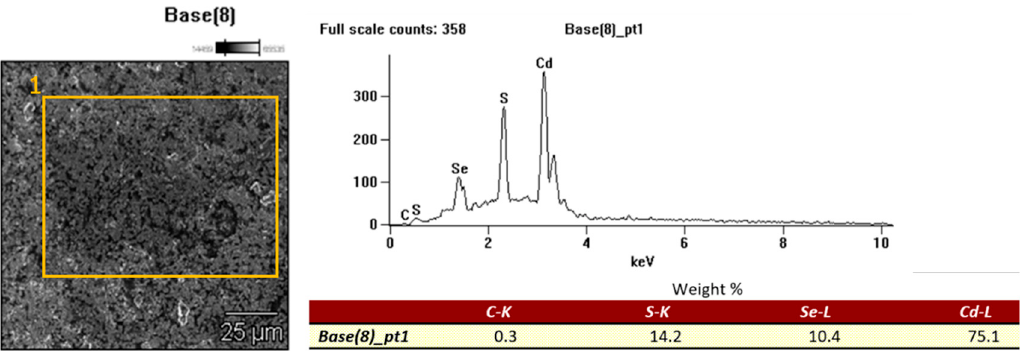
Figure 1. SEM image and EDS microanalysis of photoresistor surface. Table 6. Average content of metals in components and sub-assemblies of electronic devices.